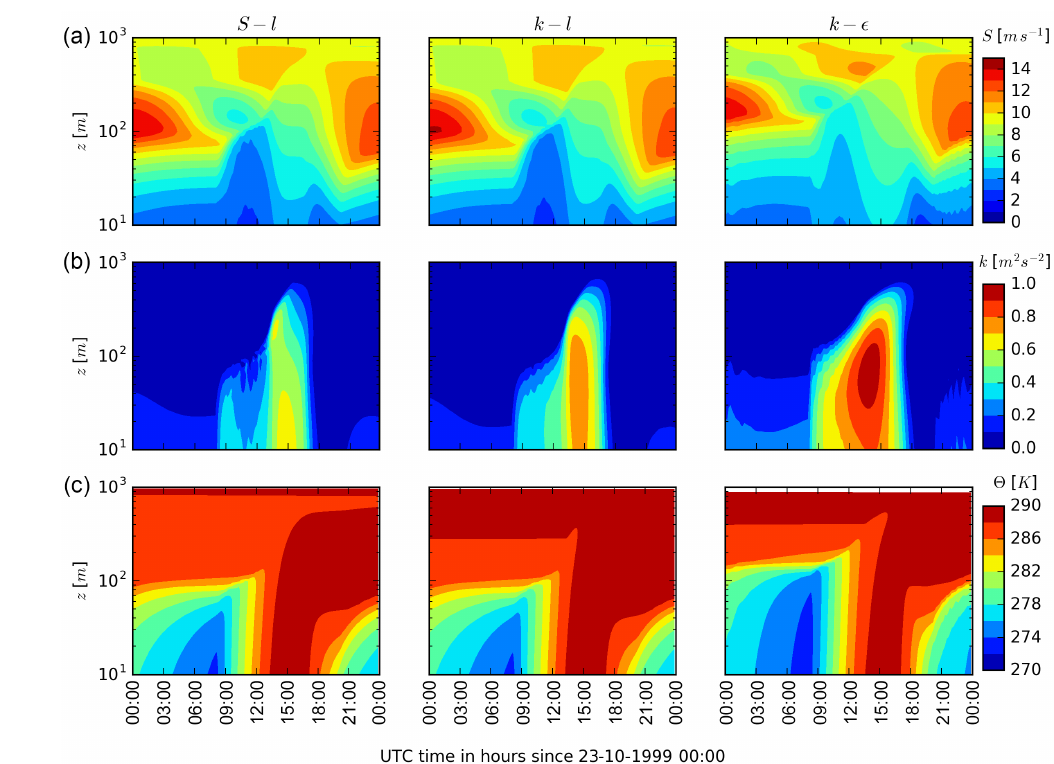
Figure 5. GABLS2 time–height contour plots of wind velocity S (top raw), turbulent kinetic energy k (middle) and potential temperature (cid:50) (bottom) for the SCM simulation based on S - l (first column), k - l (second) and k - ε (third) turbulence closure after five cyclic simulations.